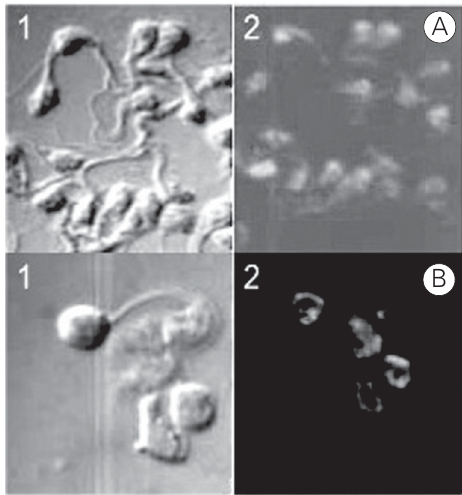
Figure 1. Reactivity of anti- (cid:1) -L- fucosidase antibodies with epi- mastigote and trypomastigote forms of Trypanosoma cruzi. The reactivity was confirmed by indi- rect immunofluorescence with p -formaldehyde-fixed parasites and visualized under a confocal microscope. A , Epimastigotes; B , trypomastigotes. 1 , Phase- contrast microscopy; 2 , fluores- cence